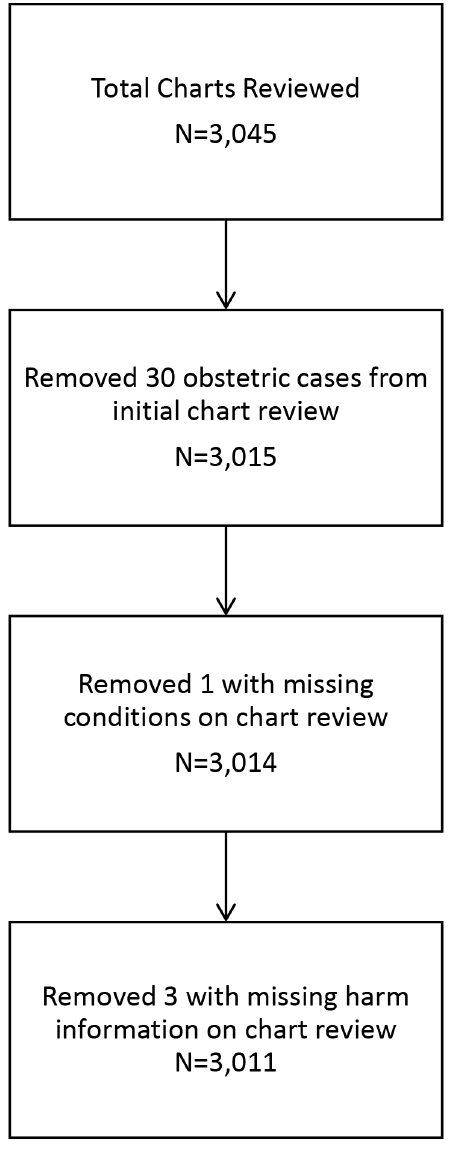
Figure 2: Flow diagram of final cohort used for chart